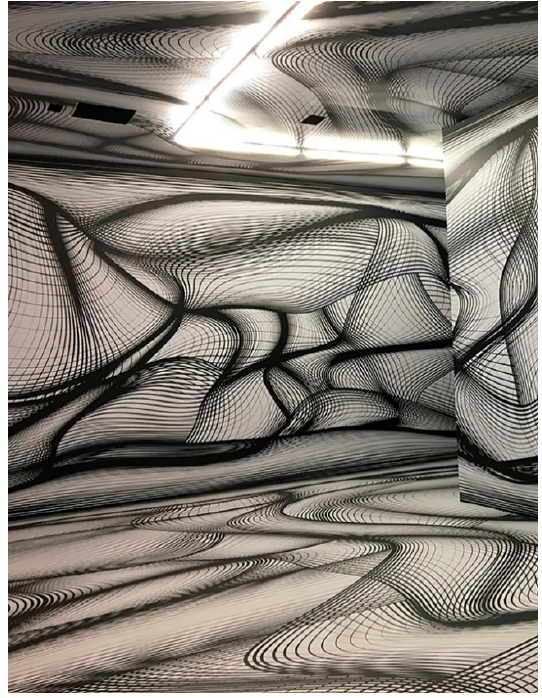
Figure 4. Untitled by Peter Kogler, Photo by Seymour Simmons.